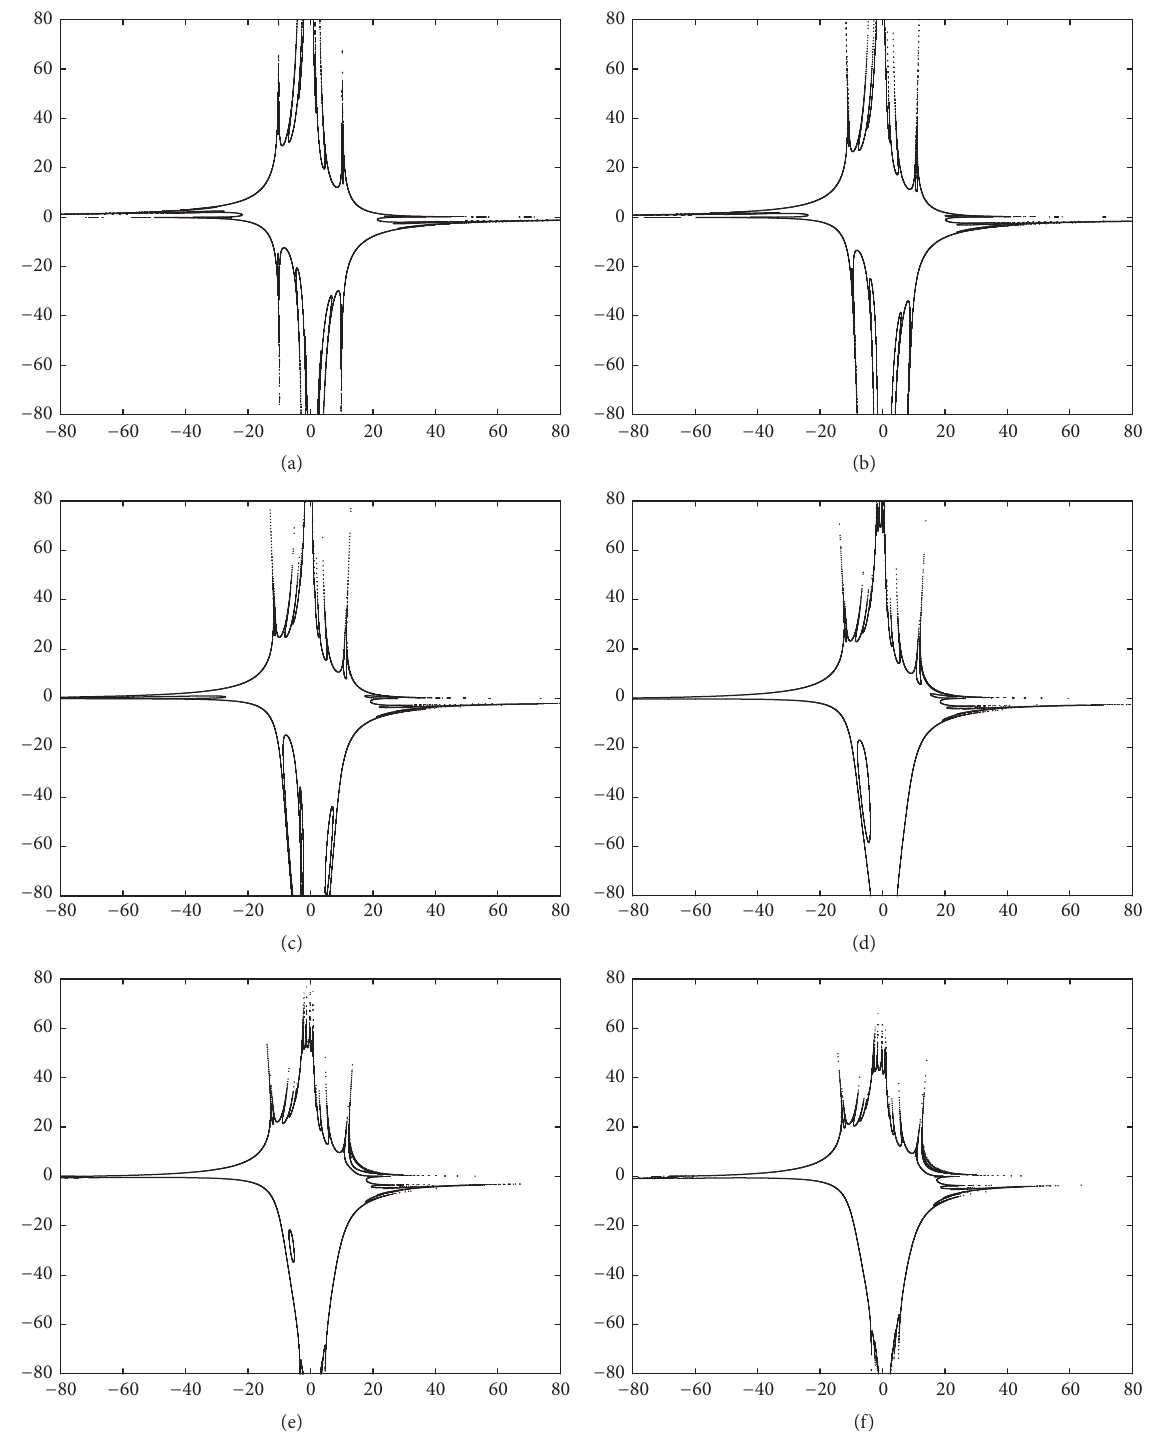
Figure 10: The change of the Julia sets of the controlled system when 𝑎 = 0.07, 𝑏 = 0.02 , and 𝛾 = 0.01 . (a) 𝑘 = 0.0005 ; (b) 𝑘 = 0.0045 ; (c) 𝑘 = 0.0085 ; (d) 𝑘 = 0.0125 ; (e) 𝑘 = 0.0165 ; (f) 𝑘 = 0.0200